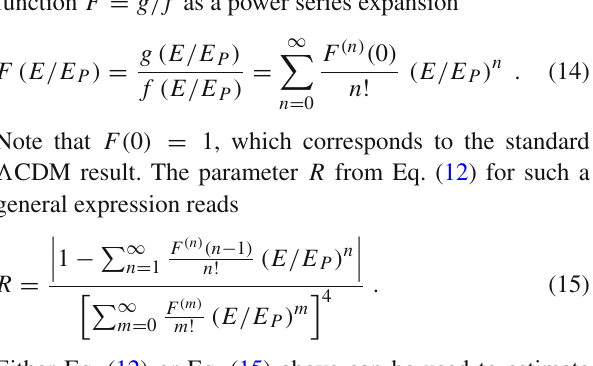
Fig. 1 R vs η for fixed energy E = E 12 (cid:2) 5 . 9 × 10 − 6